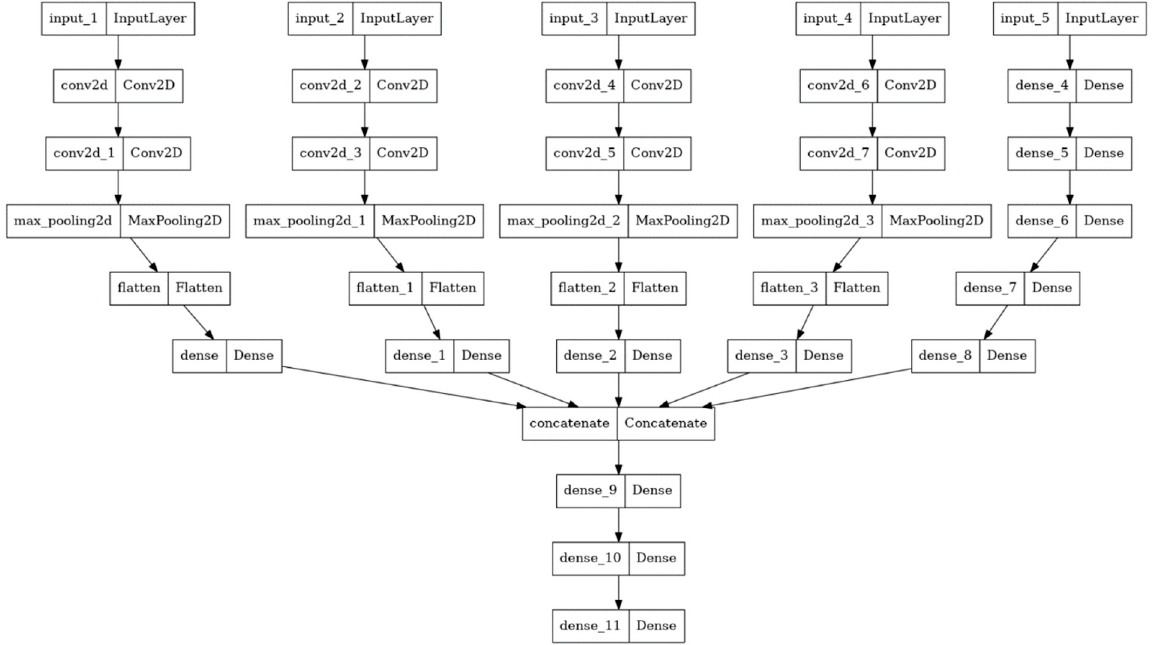
Figure 4. Model structure merged with convolutional neural network and deep neural network for storm surge forecasting.